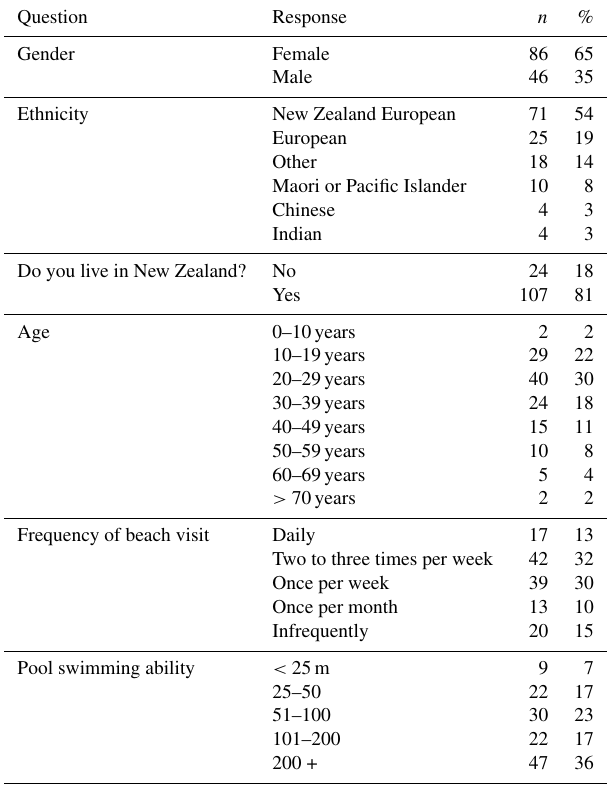
Table 2. Sample characteristics in terms of demographics, fre- quency of beach visits, and self-rated pool swimming competency ( n =